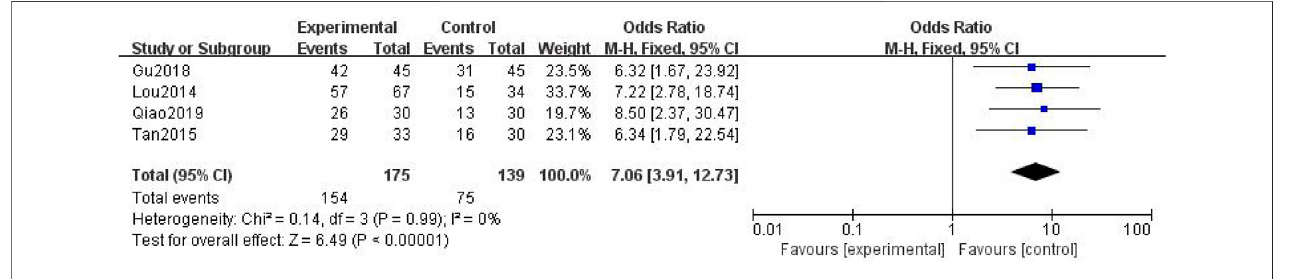
FIGURE 13 | Analgesic